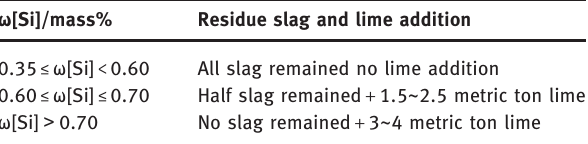
phosphorus content in molten steel.